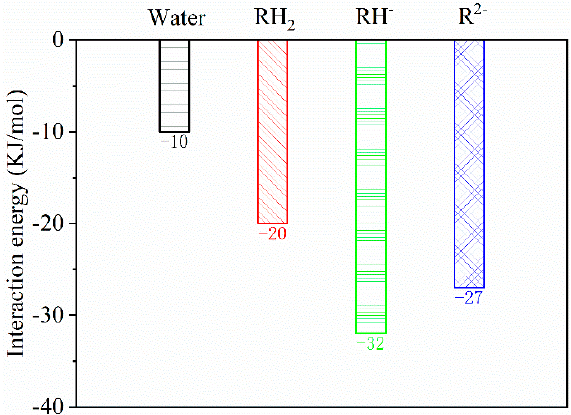
Figure 8. Interaction energy of water, RH 2 , RH − , and R 2 − on the barite (001) surface.